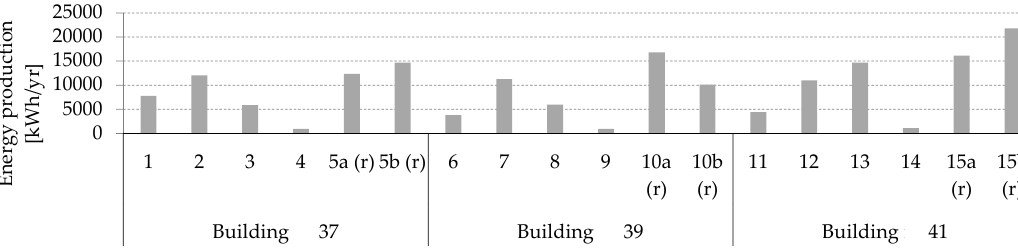
Figure 21. Average irradiation on the roofs (r) and façades in the critical area for feasibility study I.